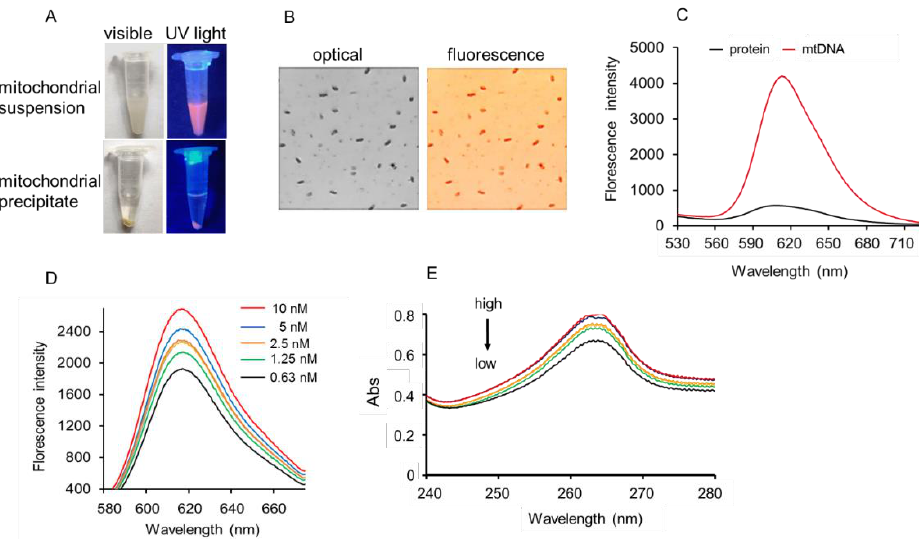
Figure 4. Assessment of binding of RC-7 to glioma mtDNA. ( A ) Isolated mitochondria. The suspended and precipitated mitochondria under visible or UV light. ( B ) The mitochondria were observed under confocal microscope. The mitochondria showed red fluorescence under fluorescence excitation (Ex 550 nm). ( C ) RC-7 bound mtDNA rather than mitochondrial protein extract. The RC-7-mtDNA binding fluorescence profiles were evaluated by fluorescence ( D ) and UV spectroscopy ( E ). Concentrations of RC-7 from high to low were 10, 5, 2.5, 1.25, and 0.63 nM, respectively.